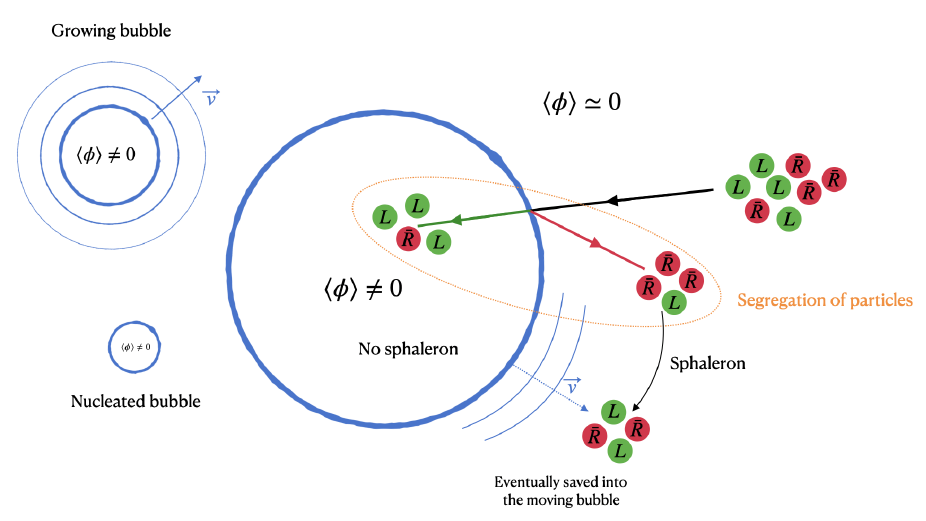
Figure 8. Sketch of electroweak baryogenesis based on nucleated bubbles and their growth. In this sketch, an equal amount of left-handed particles and right-handed antiparticles are considered (the right-handed particles and left-handed antiparticles are not participating in a sphaleron process). After particles are segregated—this is the chiral asymmetry—they are converted into a baryon asymmetry before being swallowed by the fast moving